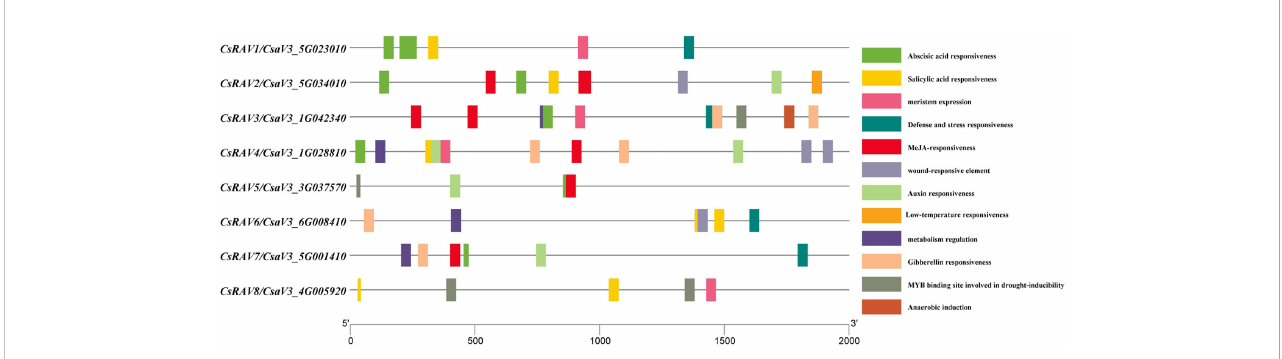
FIGURE 4 The promoter analysis of the CsRAV genes in cucumber. The potential cis -elements on the 2-kb promoter regions upstream of CsRAV genes were analysed using PlantCARE. Different colored boxes represented the corresponding cis